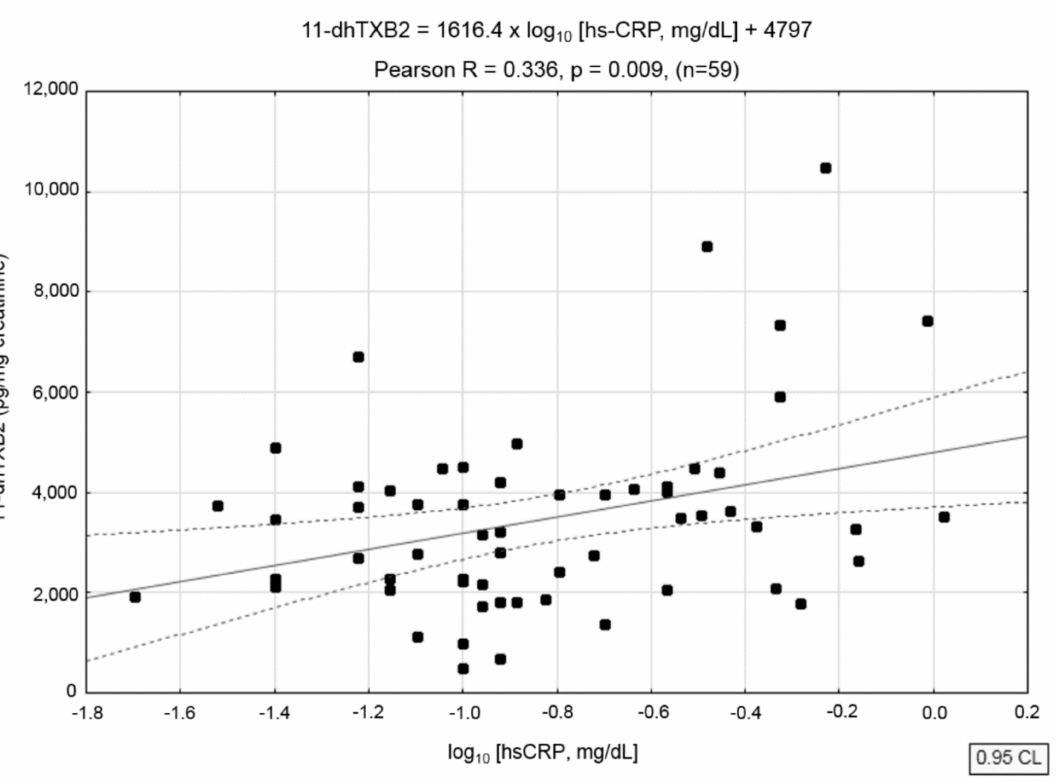
Figure 1. Correlation of urine 11-dehydro-TXB2 levels in aspirin- and statin-naive males with serum adiponectin ( upper chart ), homocysteine ( middle chart ), and hs-CRP ( lower chart ).